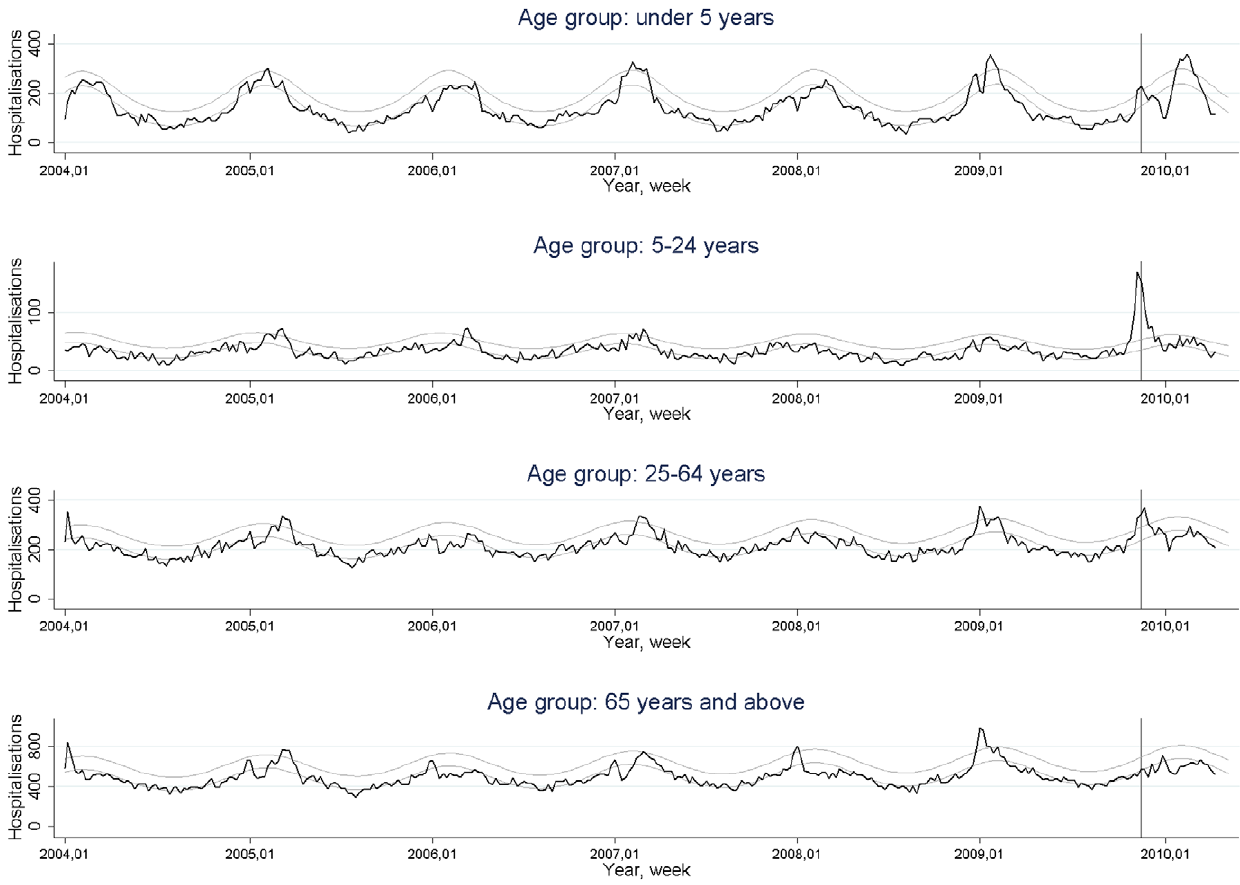
Figure 1. Time-series of weekly numbers of influenza-associated hospitalisations in 2004–2010, by age group, in Denmark. The baseline with 95% upper confidence interval is fitted to the pre-pandemic data; week 1, 2004 until week 17, 2009. The peak week of the 2009 influenza pandemic, week 47 of 2009, is indicated with vertical lines.